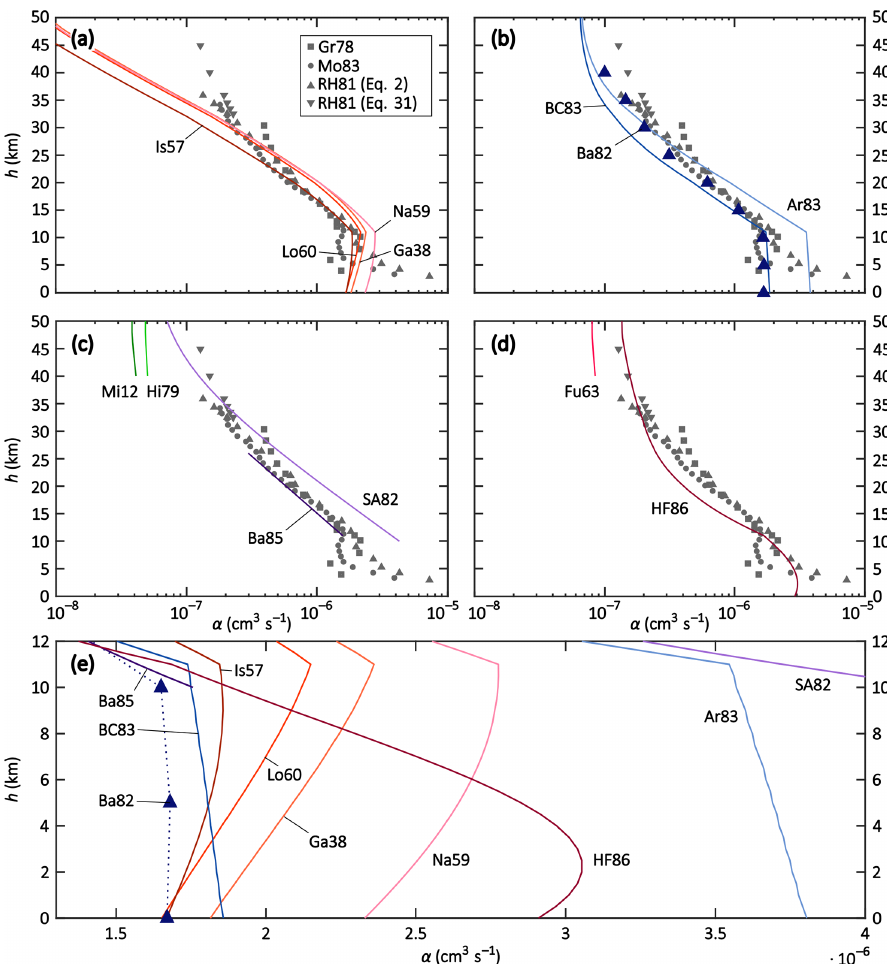
Figure 2. Altitude profiles of theories and parameterisations (solid lines), field data (grey symbols), and model simulations (purple triangles) of the recombination coefficient α for conditions of the US Standard Atmosphere. Panels (a–d) depict altitude profiles up to 50km with a logarithmic x axis; the field data are depicted in all panels for better comparability. Panel (e) shows altitude profiles up to 12km with a linear x axis. The meanings of the labels are listed in Table 2. See text for more